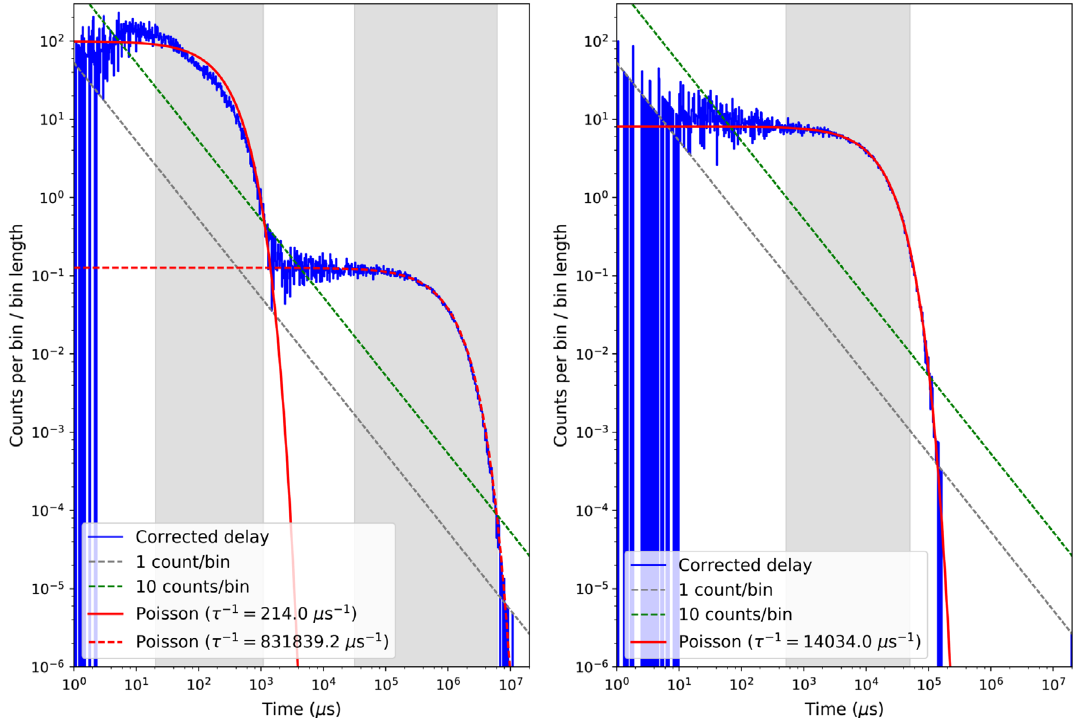
Fig. 5. The waiting time distribution (blue histogram) for cosmic ray neutrons as observed with the 3 He tube (left panel) and for the test source (right panel). The red curves show fi tted Poisson distributions, while the dashed gray and green lines indicate bins containing either 1 or 10